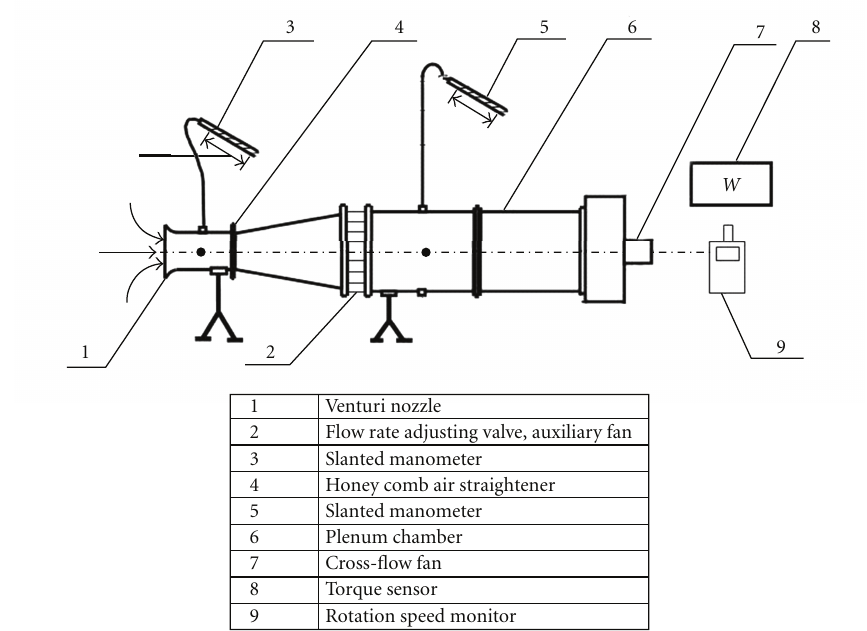
Figure 4: Schematic of the test rig used to measure fan performance.